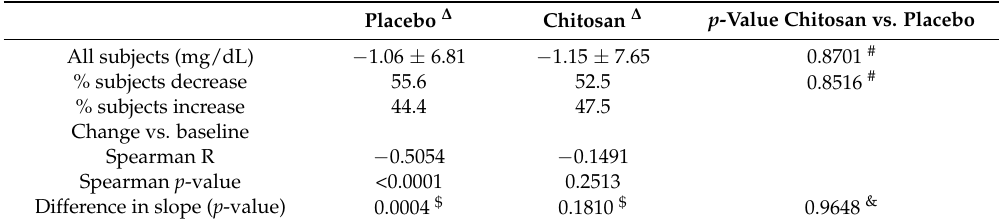
Table 6. Comparison of changes in serum high density lipoprotein (HDL) cholesterol induced by chitosan and placebo treatments. Placebo ∆ Chitosan ∆ p -Value Chitosan vs. Placebo